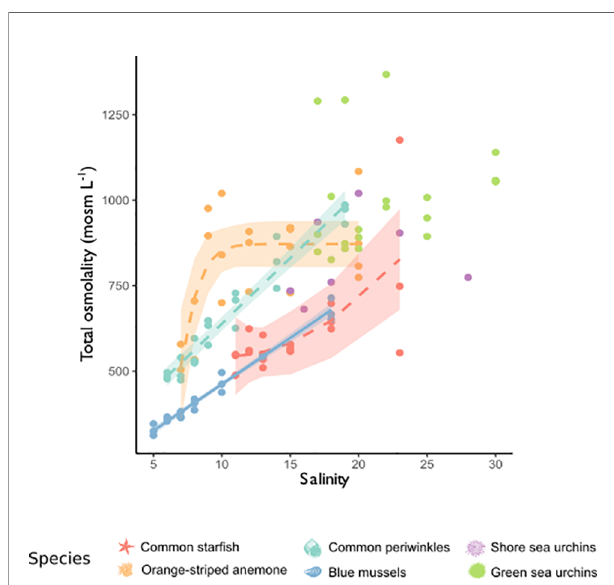
FIGURE 4 | Effect of salinity on total osmolality of tissues. Depicted is total osmolality in tissue extracts of the six study organisms: blue mussels (blue, Mytilus sp.), common periwinkles (turquoise, Littorina littorea ), green sea urchins (green, Strongylocentrotus droebachiensis ), sea stars (red, Asterias rubens ), orange-striped anemones (orange, Diadumene lineata ) and shore sea urchins (purple, Psammechinus milliaris ). Total osmolality (mosm L-1) is shown on the y-axis and salinity is depicted on the x-axis. Models were chosen according to best fi t and their predicted values are depicted by lines. A. rubens : Quadratic model (R 2 = 0.4486, df = 2, 15, F-value = 6.1, p-value = 0.0115), D. lineata : 3-parametric logistic model (Residual S.E. = 115.01, df = 17, b = -1.16, d = 871.90, e = 6.69), L. lineata : Linear model (R 2 = 0.9411, df = 1, 19, F-value = 303.7, p-value < 0.001), Mytilus sp.: Linear model (R 2 = 0.9793, df = 1, 19, F-value = 896.9, p-value < 0.001). No model is shown for shore and green sea urchins, because there was no signi fi cant relationship. Con fi dence intervals (95%) are shown as shaded area. b = y- intercept, d = upper limit, e = steepness of increase as x.